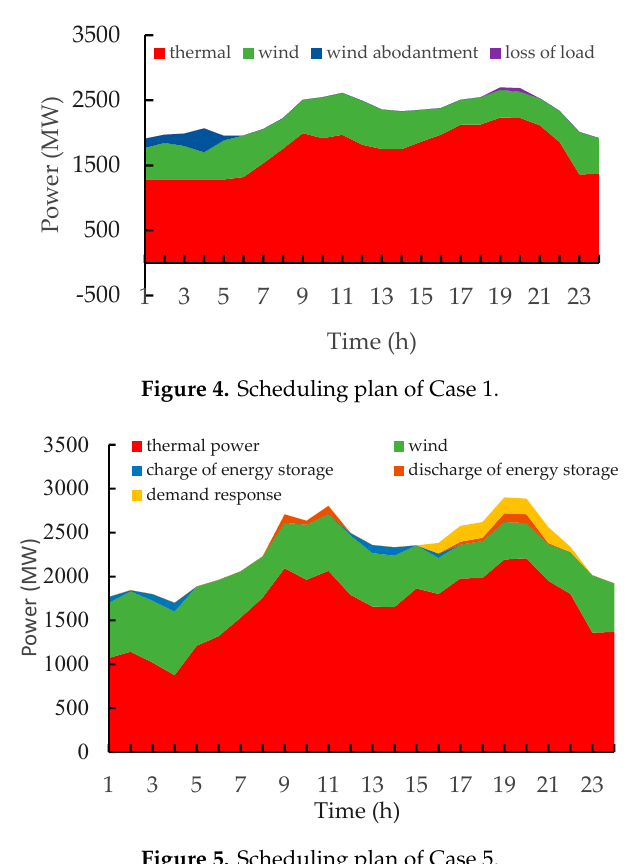
Figure 5. Scheduling plan of Case 5.